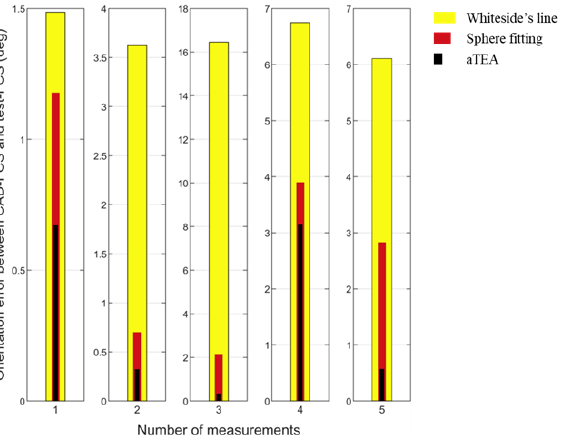
Figure 8. Repeatability of the current techniques to mark the transverse axis for FCS.